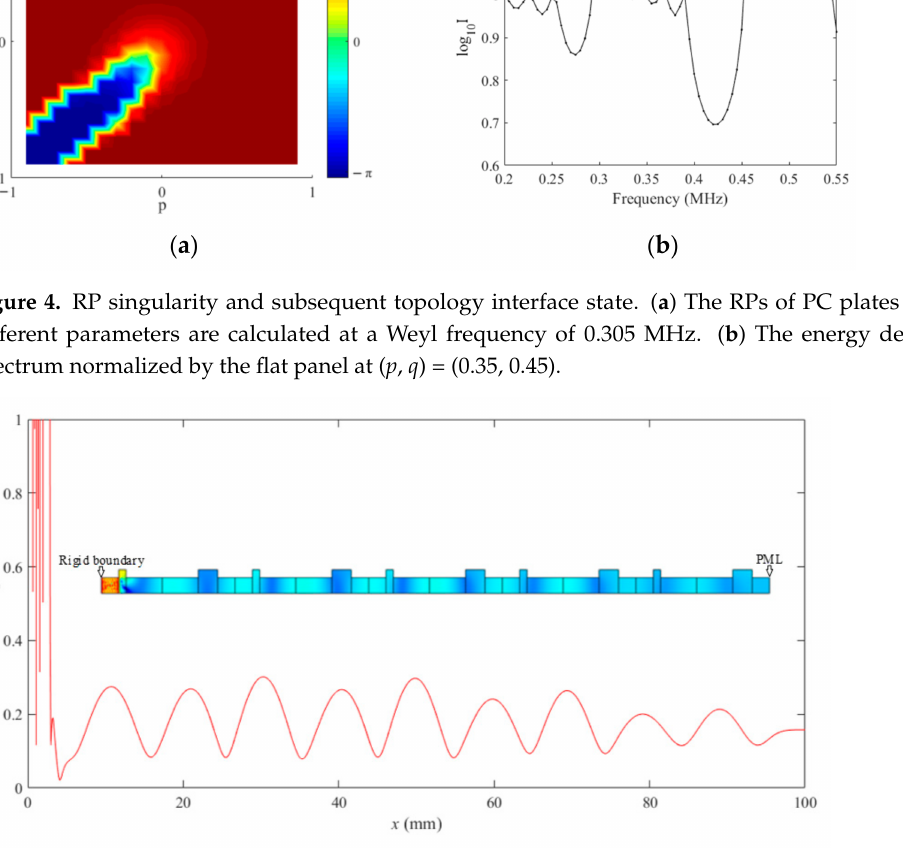
Figure 5. The displacement distribution of the PC plate at a Weyl frequency of 0.305 MHz with ( p , q ) = (0.35,